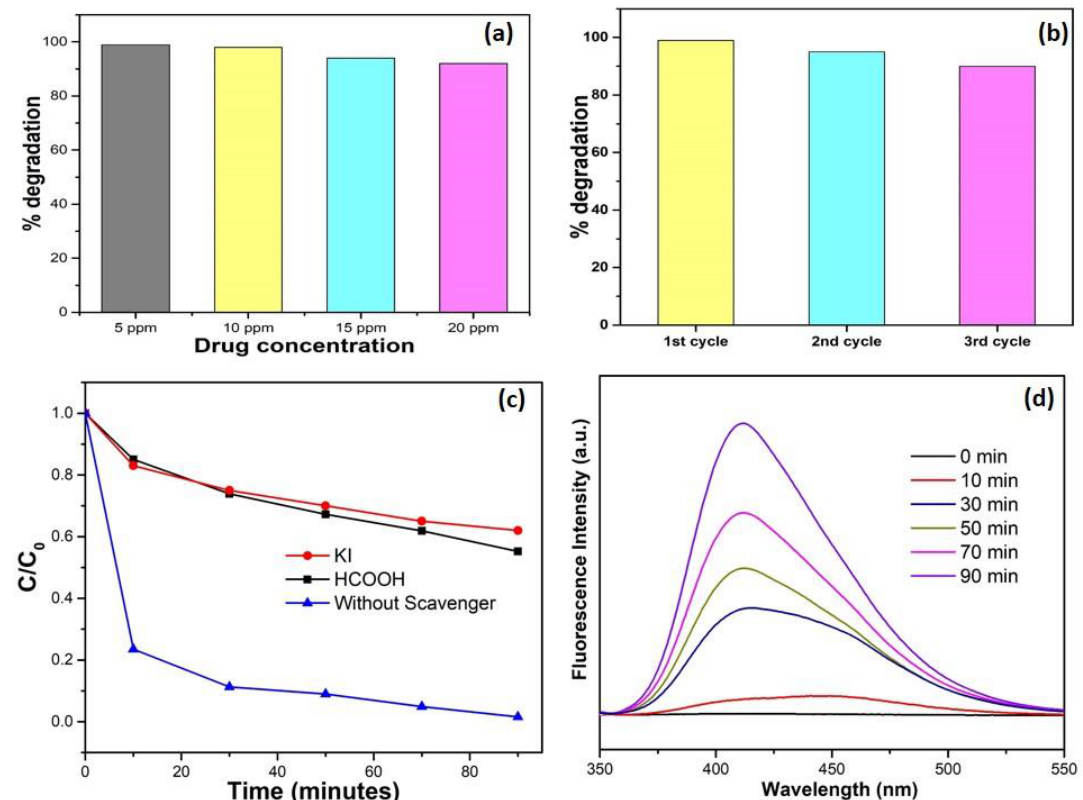
Figure 7. ( a ) Influence of initial concentration of drug on the degradation of levofloxacin. ( b ) No. of consecutive runs depicting recyclability of Bi 2 WO 6 / C-dots / TiO 2 . ( c ) Influence of scavengers on the photocatalytic activity of catalyst (drug conc. 10 ppm, pH 7, catalyst (Bi 2 WO 6 /C-dots/TiO 2 ) dosage 0.075 g/L). ( d ) PL spectra of TPA in presence of catalyst (Bi 2 WO 6 /C-dots/TiO 2 ) at λ ex = 315 nm. Nanomaterials 2020 , 10 , x FOR PEER REVIEW